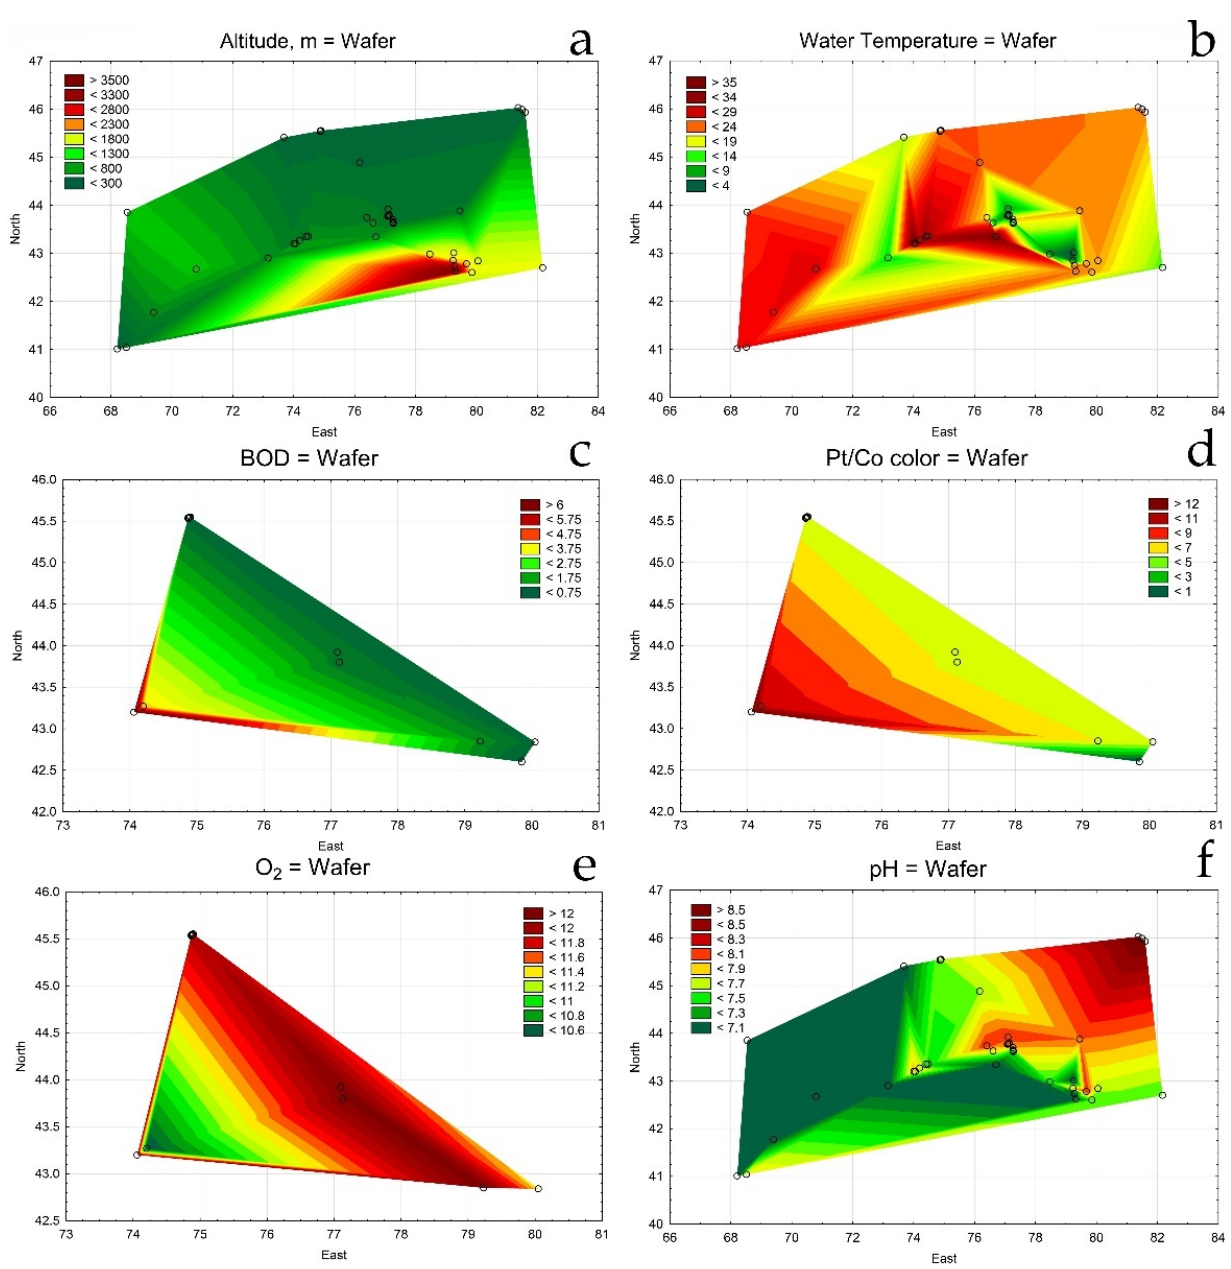
Figure 2. Statistical maps for environmental variables distribution on the studied area of south and southeast Kazakhstan in 2019–2022. Altitude ( a ); Water temperature ( b ); BOD ( c ); Pt/Co color ( d ); oxygen ( e ); pH ( f ). The legend key shows the variable value range.